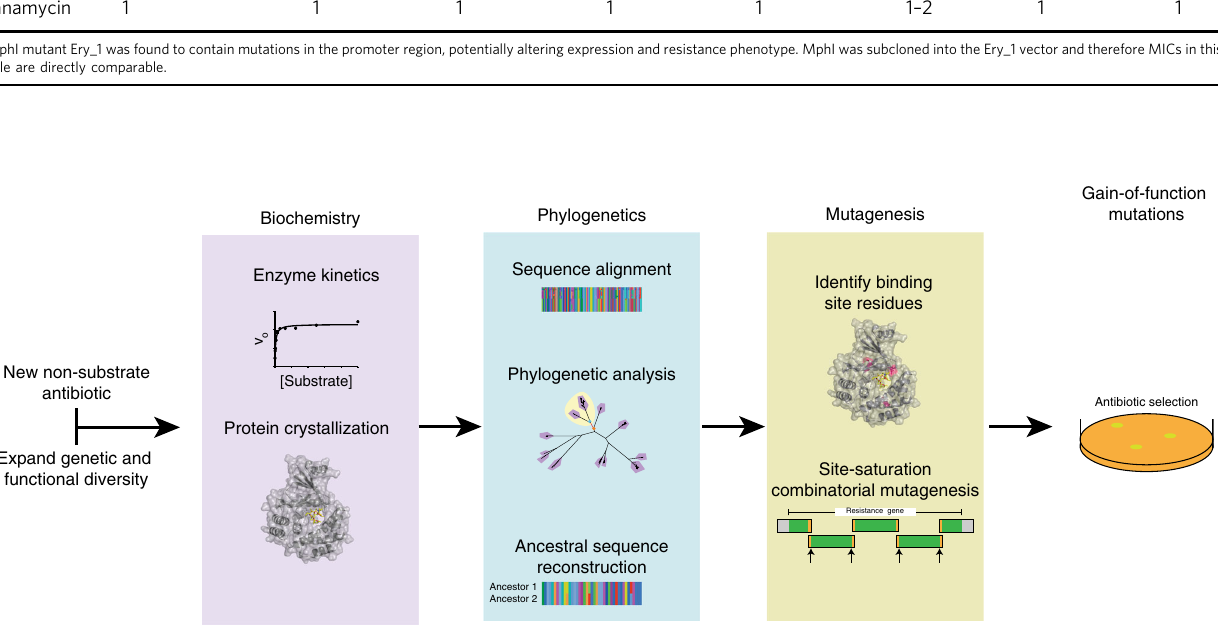
Fig. 7 Work fl ow for assessing the evolvability of resistance enzymes to new antibiotics using biochemistry, phylogenetics, and mutagenesis. First, expand the known functional diversity of an enzyme class by identifying homologs that include the new antibiotic in its substrate range. Characterize the enzymes using steady-state kinetics and solve the protein structure of at least one homolog. Use the biochemical experiments to correlate functional diversity with phylogenetic diversity for identifying the last common ancestor of each functional subtype (e.g., ancestor of narrow range Mphs and wide range Mphs, respectively). The difference in ancestral protein sequences are residues possibly involved in substrate speci fi city, which should be prioritized based on proximity to the substrate-binding site in the protein structure. Target these residues for mutagenesis, preferably by saturation mutagenesis at each position, in combination (site-saturation combinatorial mutagenesis). Identify residues expanding substrate speci fi city by sequencing technologies that generate reads covering the whole gene (e.g., Sanger, Nanopore,